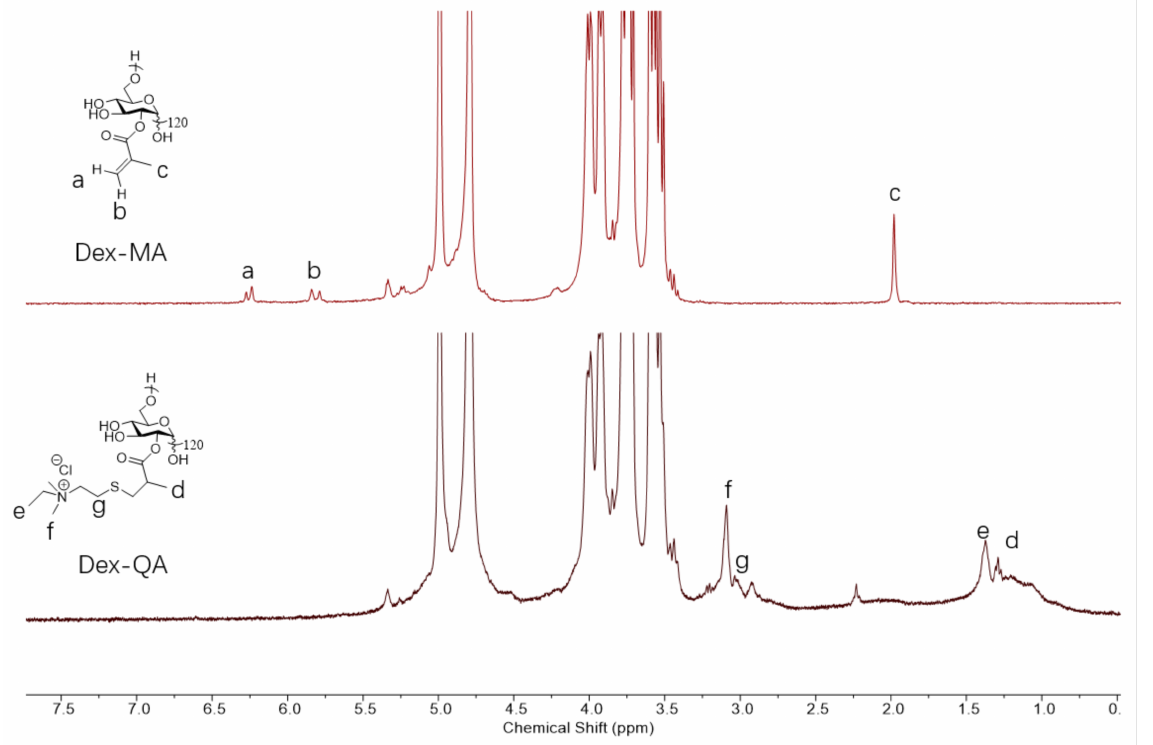
Figure 1. 1 H-NMR spectra of DEX-MA and